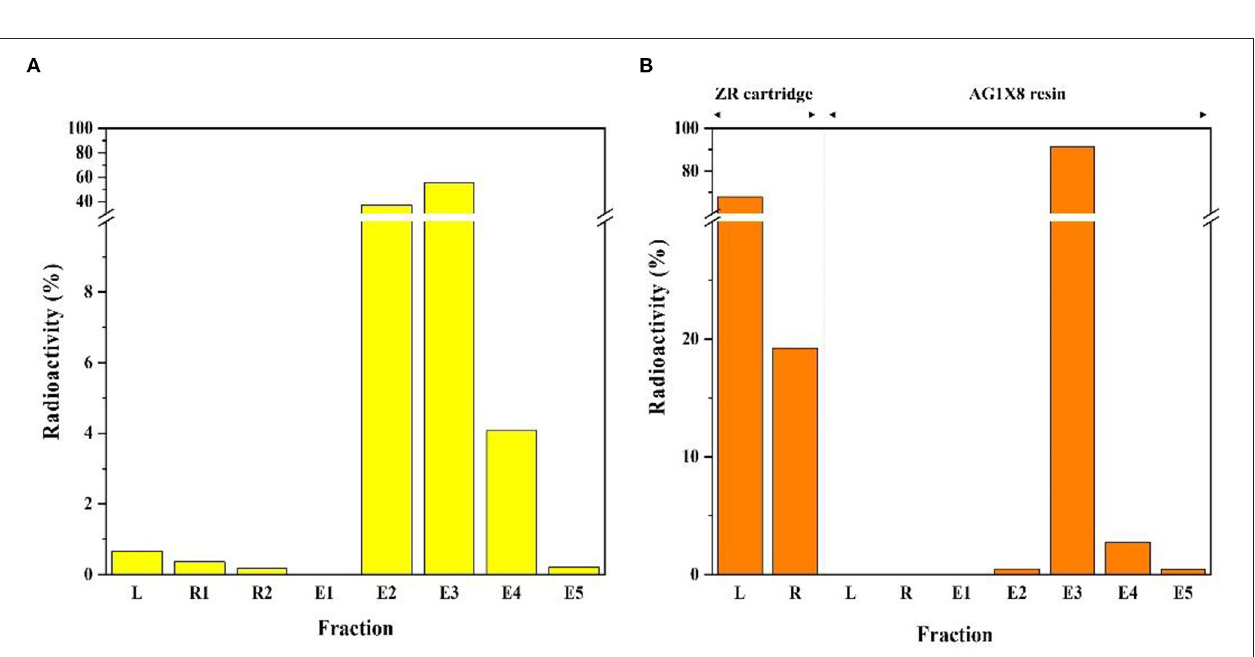
FIGURE 4 | Elution profile of radioactive copper separation from the irradiated target materials (A) 64 Cu and (B) 67 Cu.